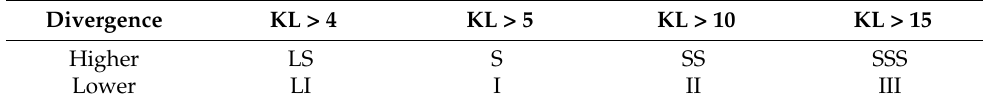
Table 3. Nomenclature used to classify the differences between distributions.